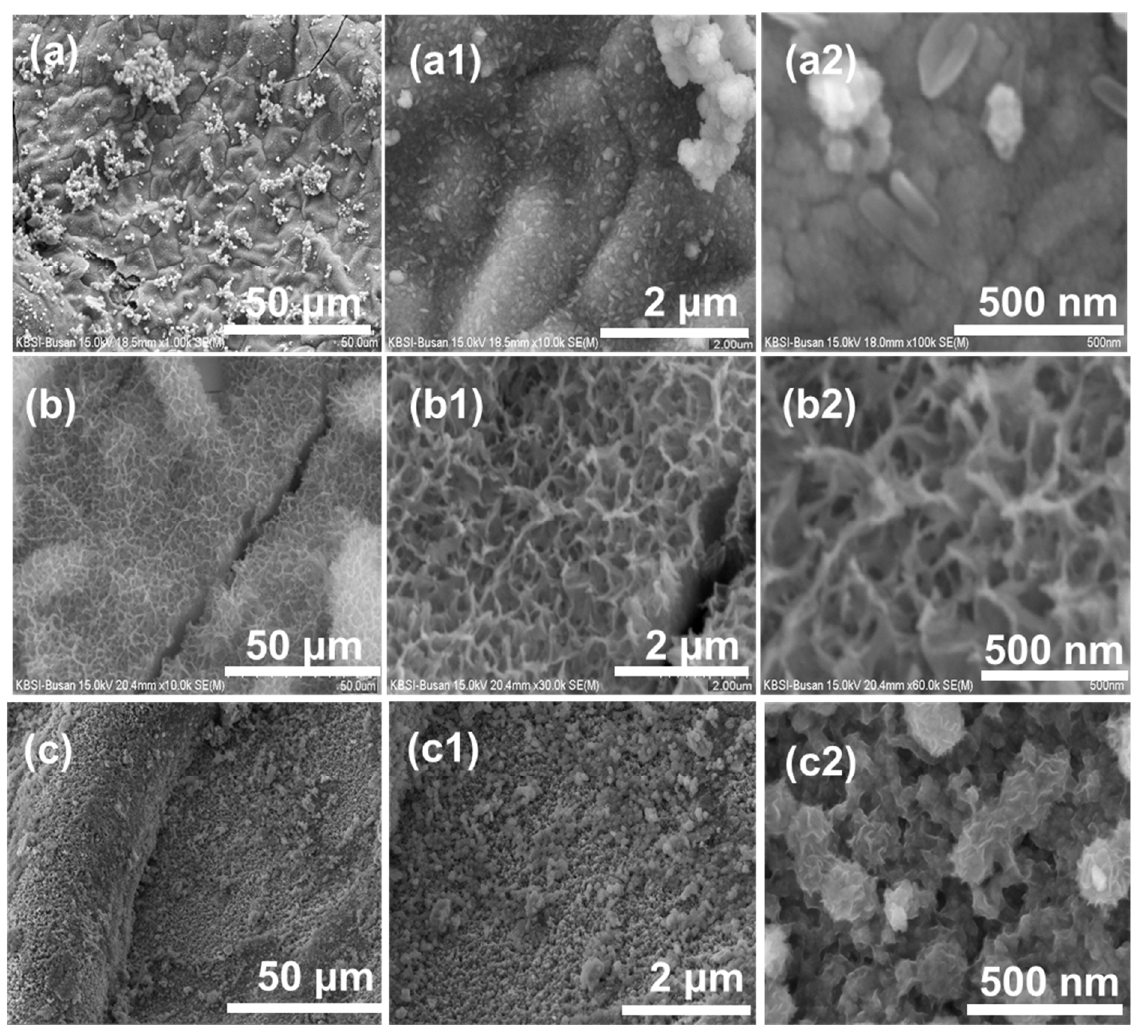
Figure 3. FE-SEM images ( a , a1 , a2 ) of MCO, ( b , b1 , b2 ) of NiO, and ( c , c1 , c2 ) of MCO/NiO under different magnifications. CV, GCD, and electrochemical impedance spectroscopy (EIS, 0.01–100 kHz) experi-